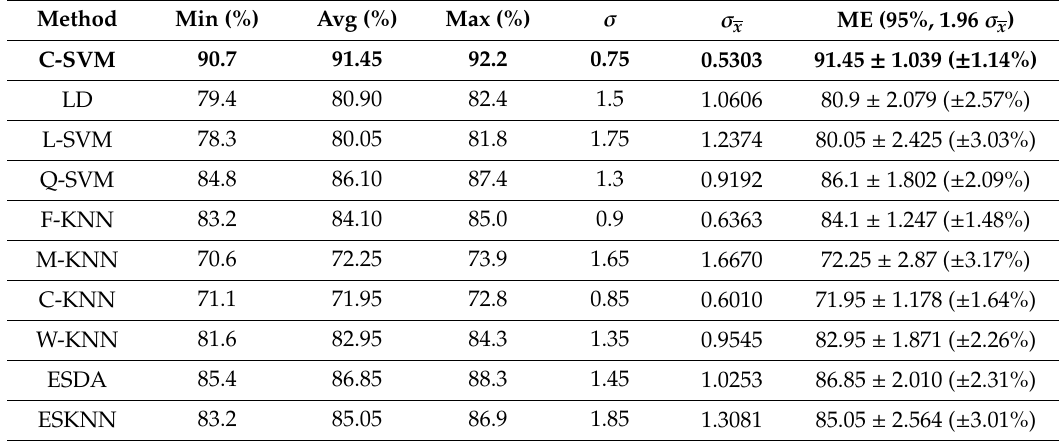
Table 5. Analysis of proposed method on original data. Best values are shown in bold.